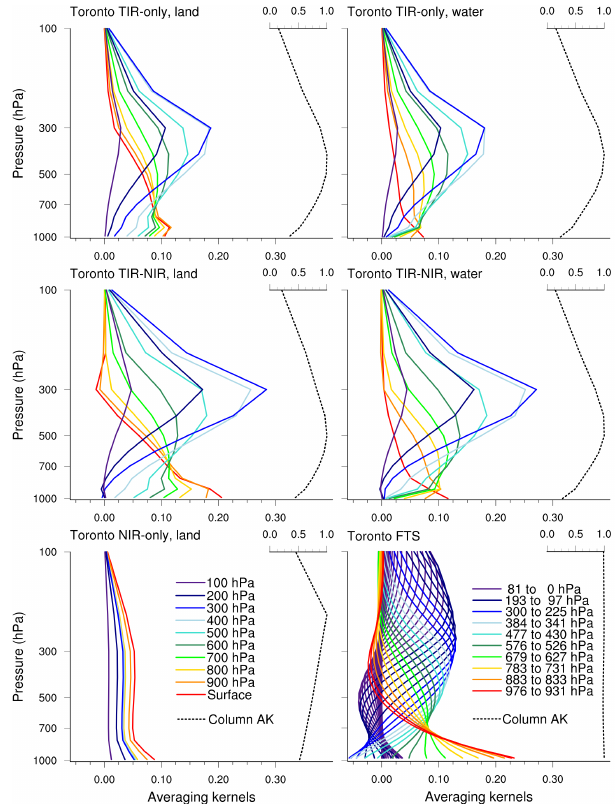
Figure 2. Mean AKs for MOPITT (top two rows and bottom left) and FTS (bottom right) at Toronto. Full averaging kernel matrices are shown with solid lines. The corresponding total column averag- ing kernel is shown with a dashed line. MOPITT column AKs are